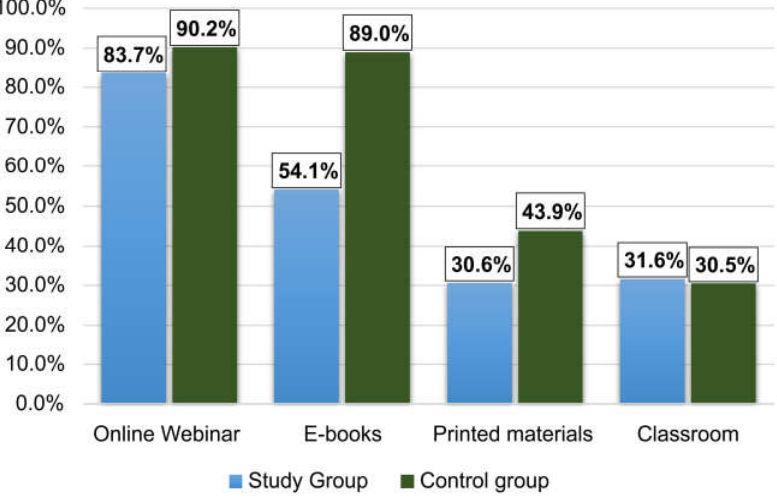
Figure 4. Educational programme model preferences.